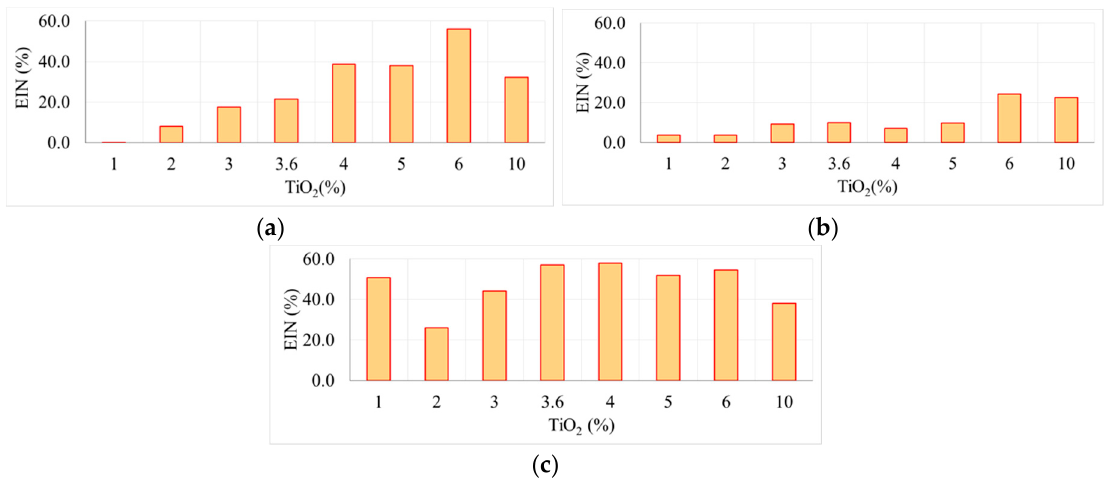
Figure 5. Efficiency Index of Nanoparticles: ( a ) Non-UV test specimens, ( b ) 1 H UV test specimens, ( c ) 1+ 24 h UV test specimens.